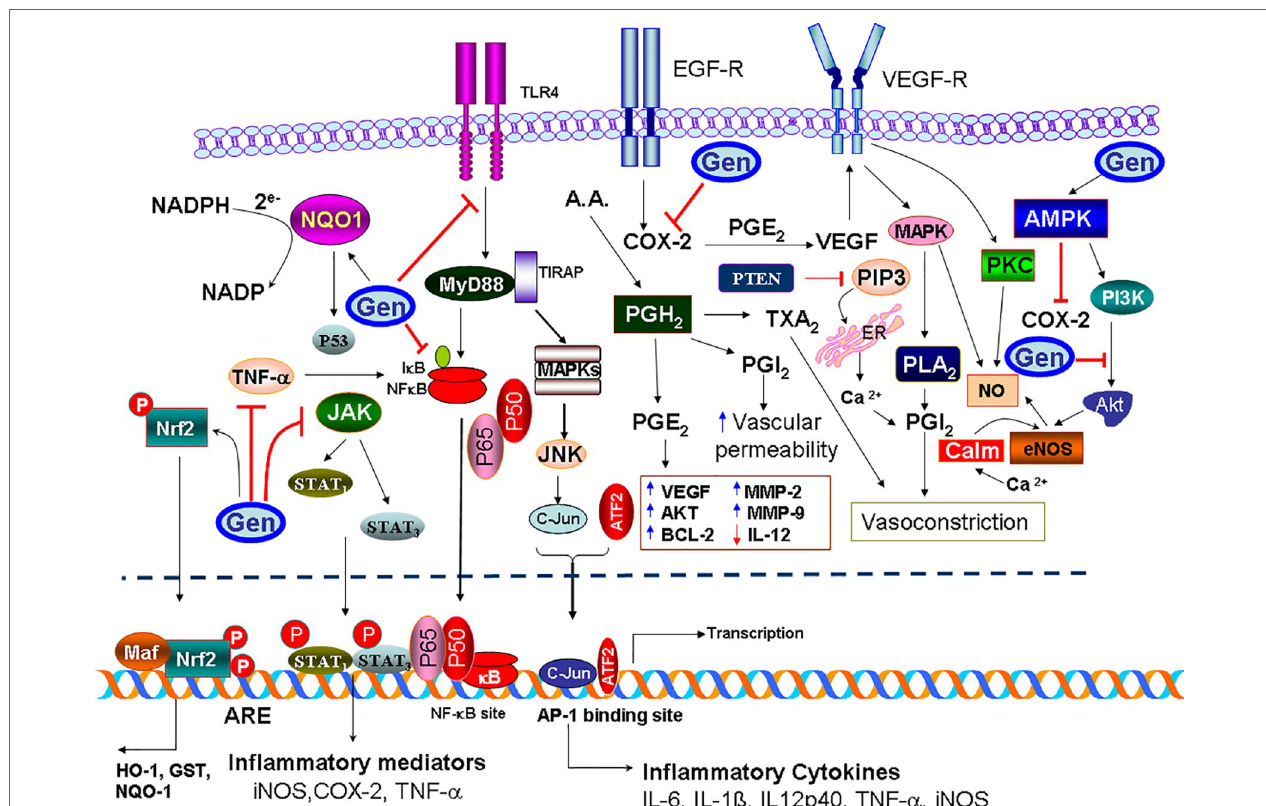
FIGURe 7 | Illustration of antimetastatic potential of genistein (Gen) in cancer. Genistein activates genistein-mediated activated protein kinase (AMPK)/mitogen-activated protein kinase (MAPK)/protein kinase C (PKC) pathways; the downstream of these sequences is the activation of neuronal nitric oxide synthase (nNOS), which activates the production of NO that possess a strong antioxidant/anti-inflammatory activity. Genistein also inhibits the activity of cycloxygenase-2 (COX-2), whether through the activation of AMPK pathway, or by inactivation of PIP3 pathway. Notably, COX-2 causes upregulation of vascular endothelial growth factor (VEGF) and VEGF-R activation. Further, the overexpression of COX-2 promotes the production of PGH 2 , which further metabolized to prostaglandin E 2 (PGE 2 ) , prostacyclin (PGI2), and thromboxane A 2 (TXA 2 ). Genistein inactivates TLR4 dimerization, thus abolishes MyD88 or TIR-domain-containing adapter-inducing interferon-β (TRIF) to activate nuclear factor-κB (NF-κB), so inhibit its translocation into the nucleus, and that prevents the upregulation of proinflammatory cytokines. Genistein possesses a strong inhibitory effect on oxidative stress by activating the nuclear factor erythroid 2-related factor 2 (Nrf2)-heme oxygenase-1 (HO-1)/NAD(P)H dehydrogenase (quinone) 1 (NQO1) pathway. Since, genistein is able to activate the Nrf2/NQO1 pathway. After being phosphorylated, Nrf2 activates antioxidant response element (ARE) and enhances transcription of Nrf2-regulated genes including NQO-1, HO-1, and glutathione S-transferase (GST). Also, Genistein has a potent anti-inflammatory effect through prevention of tumor necrosis factor-α (TNF-α)-induced NF-κB translocation into the nucleus, and inhibition of MAPKs/c-Jun N-terminal kinase (JNK)/c-Jun pathway, which decline the induction of the inflammatory mediators. Genistein also abolishes the activation of signal transducer and activator of transcription 1 (STAT1)/ signal transducer and activator of transcription 3 (STAT3) and prevents their translocation into the nucleus through downregulating the activity of JNK.